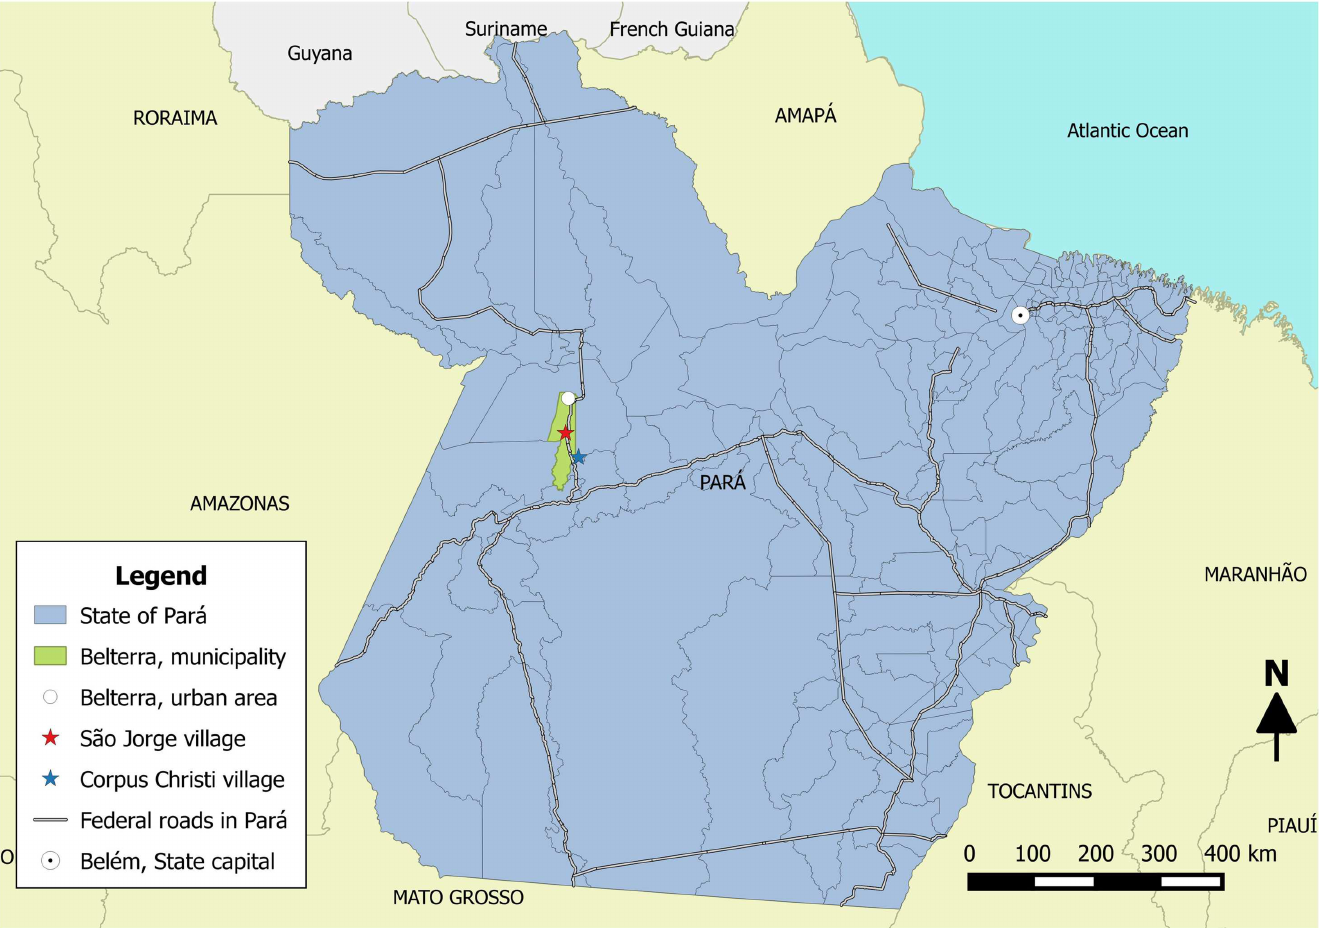
Fig 5. Map of study area. Municipality of Belterra in western Para´, and the villages of São Jorge at Km 92 and Corpus Christi at Km 135 on the Santare´m-Cuiaba´ highway.